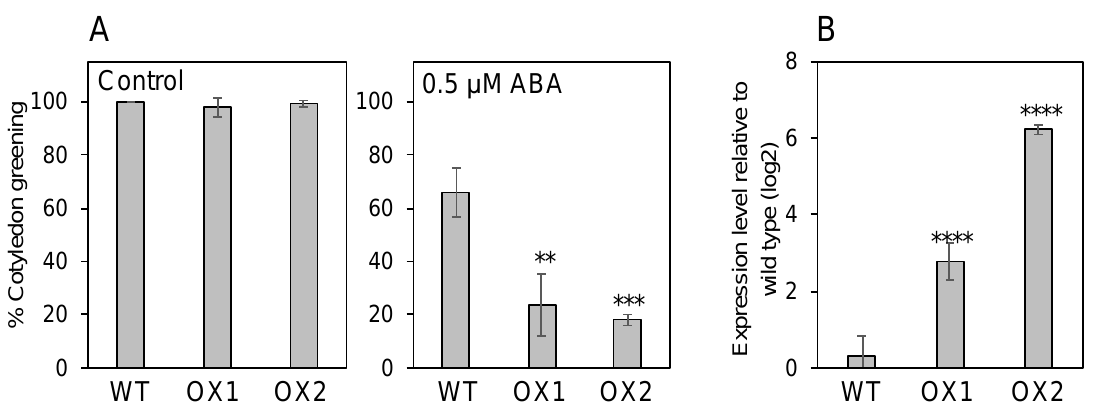
Figure 7. Overexpression of NPF5.1 enhances ABA sensitivities during germination. ( A ) Cotyledon greening of wild type (WT) and two independent transgenic lines that overexpress NPF5.1 (OX1 and 2) on control media without supplementation of ABA or media containing 0.5 µ M ABA scored at 4 d (control) and 7 d (0.5 µ M ABA) after stratification. ( B ) Expression levels of NPF5.1 in 7-d-old seedlings of wild type (WT) and two independent transgenic lines that overexpress NPF5.1 (OX1 and 2). Asterisks indicate statistically significant differences compared to the wild type determined by Dunnett’s multiple comparison test (** p < 0.01; *** p < 0.001; **** p <